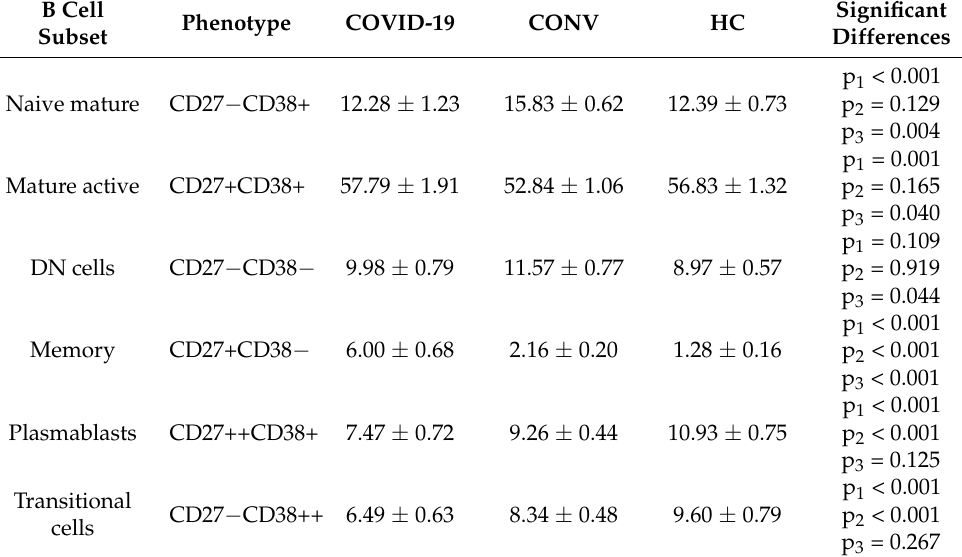
Table 2. The percentage of B-cell subsets assessed by using CD27 vs. D38 classification in patients with acute COVID-19 (COVID-19, n = 64), COVID-19 convalescent patients (CONV, n = 55) and healthy control (HC, n = 44). The quantitative data (% with CD19+ subset) are presented as mean and standard error of the mean (Mean ±